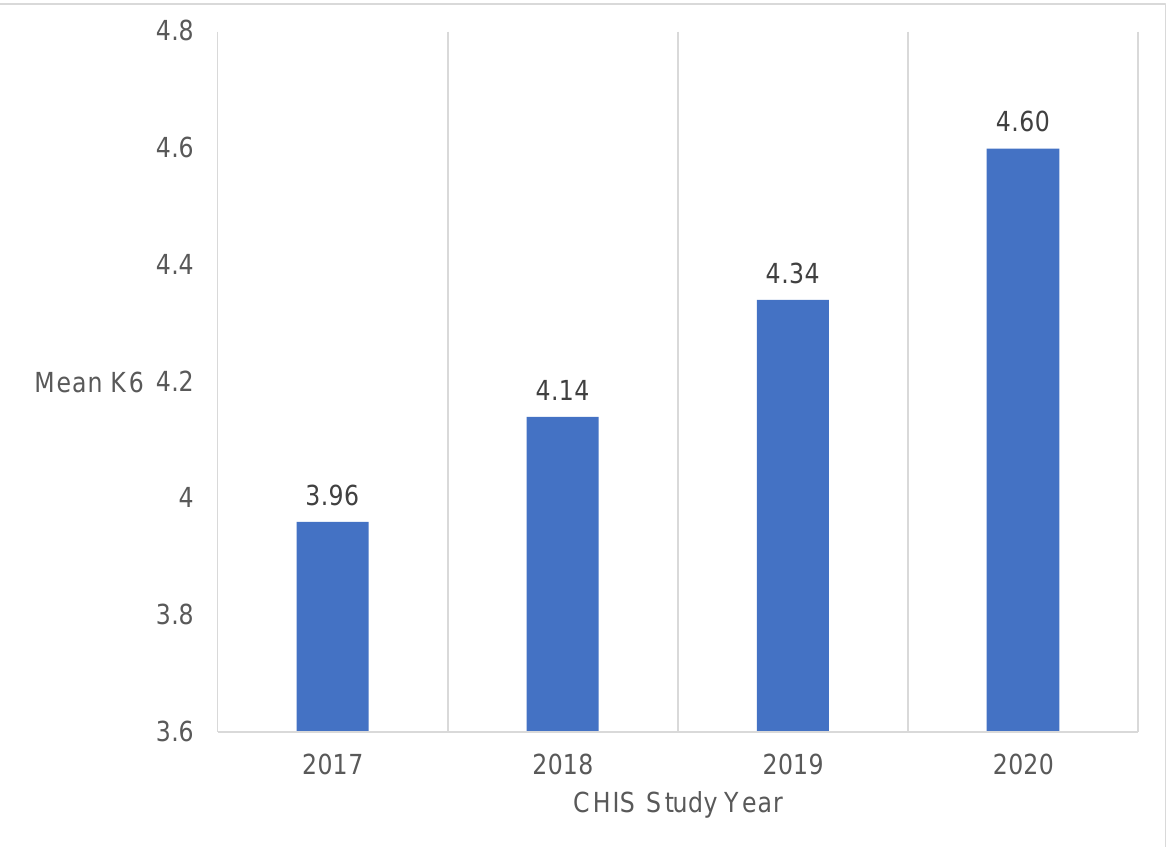
Figure 1. Mean Levels of Psychological Distress in CHIS 2017-2020.